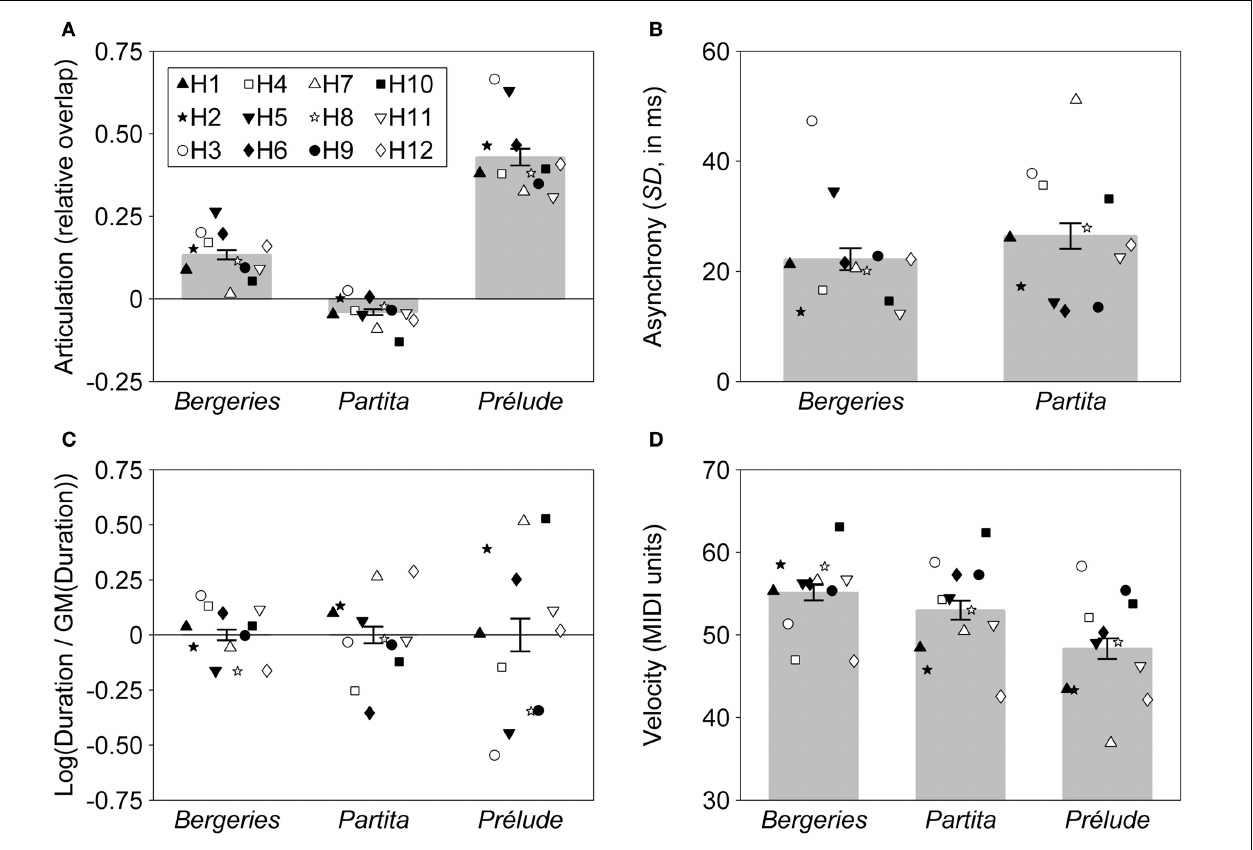
FIGURE 1 | Mean values for each of the four expressive parameters, for all three pieces. Each individual harpsichordist (identified as H1, H2, ..., H12) is represented by a unique symbol. Each symbol represents the average of two recordings by the same performer. Error bars represent the standard error of the mean. (A) Articulation, measured as relative overlap (negative values correspond